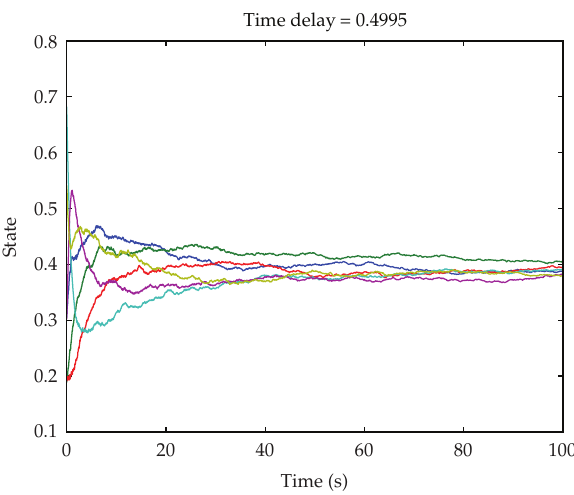
Figure 1: State trajectories under protocol (cid:7) 2.11 (cid:8) and a (cid:7) t (cid:8) (cid:6) 1 / (cid:7) t (cid:9) 1 (cid:8) .